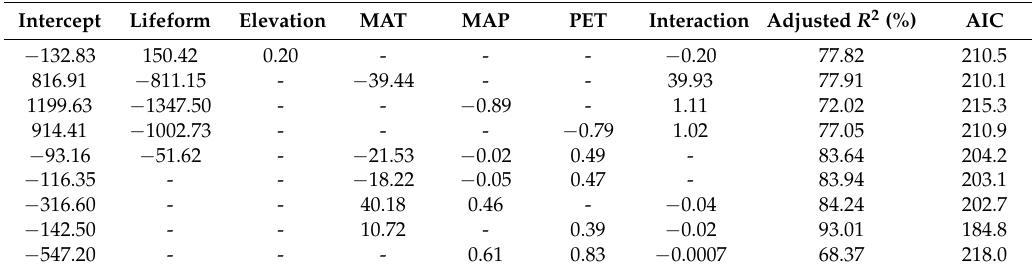
Table 1. Regression coefficients of the multivariate models for the main variables explaining species richness. P -values for all models were less than 0.001. MAT, mean annual temperature; MAP, mean annual precipitation; PET, potential evapotranspiration; AIC, Akaike information